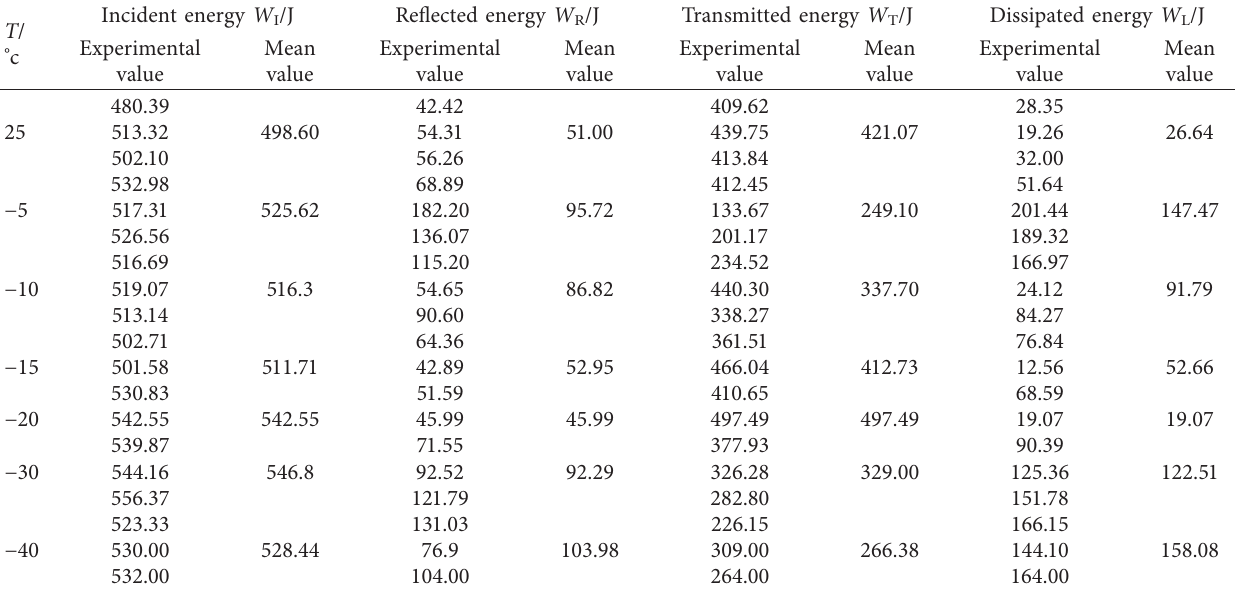
Figure 14: Failure modes of saturated marble under different temperatures. (a) 25 ° C; (b) − 5 ° C; (c) − 10 ° C; (d) − 15 ° C; (e) − 20 ° C; (f) − 30 ° C; (g) − 40 ° C. Table 2: Energy distribution statistics with the SHPB dynamic impact